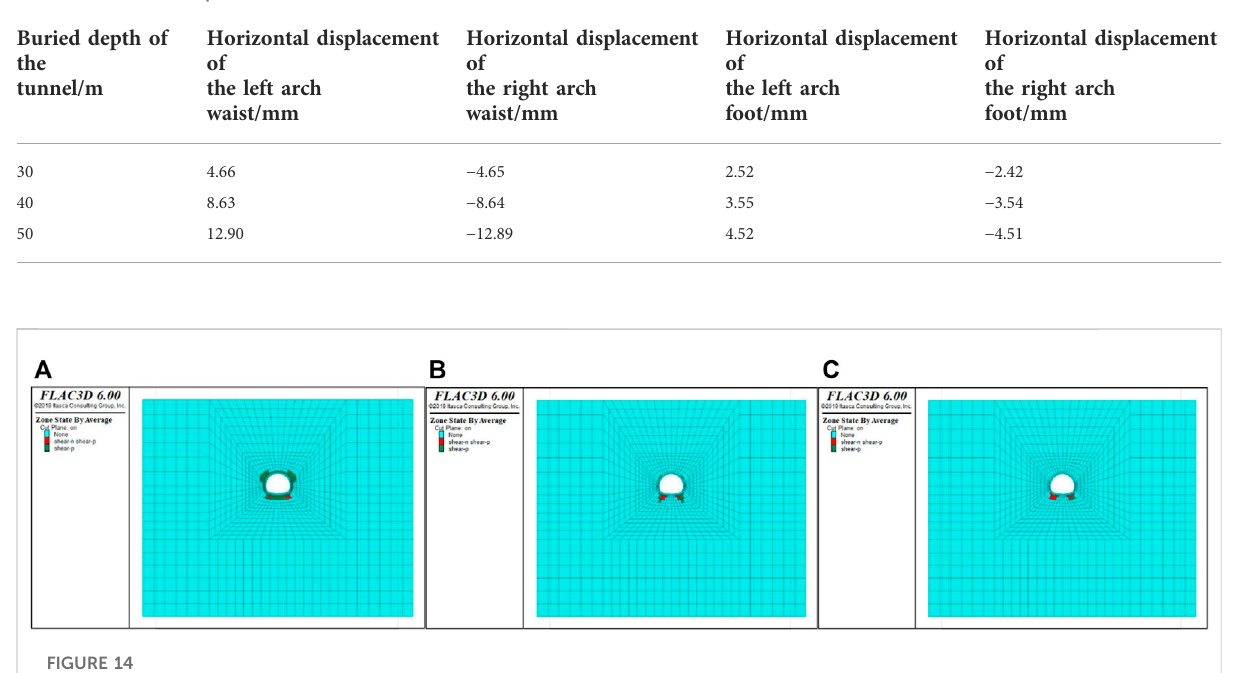
TABLE 5 Horizontal displacement values of the tunnel arch waist and foot.